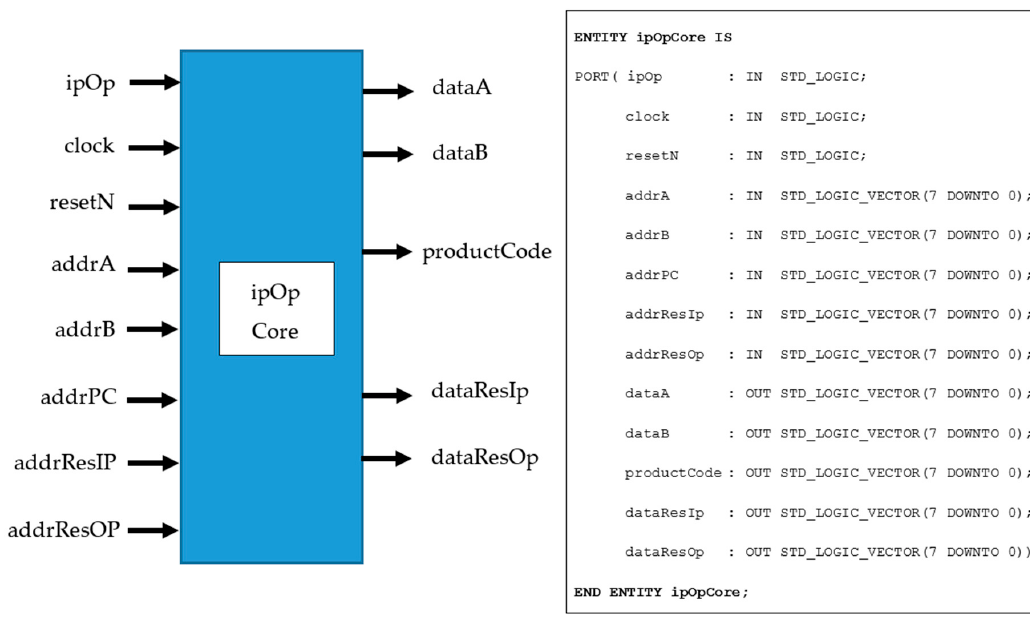
Figure 4. ipOpCore case study design.